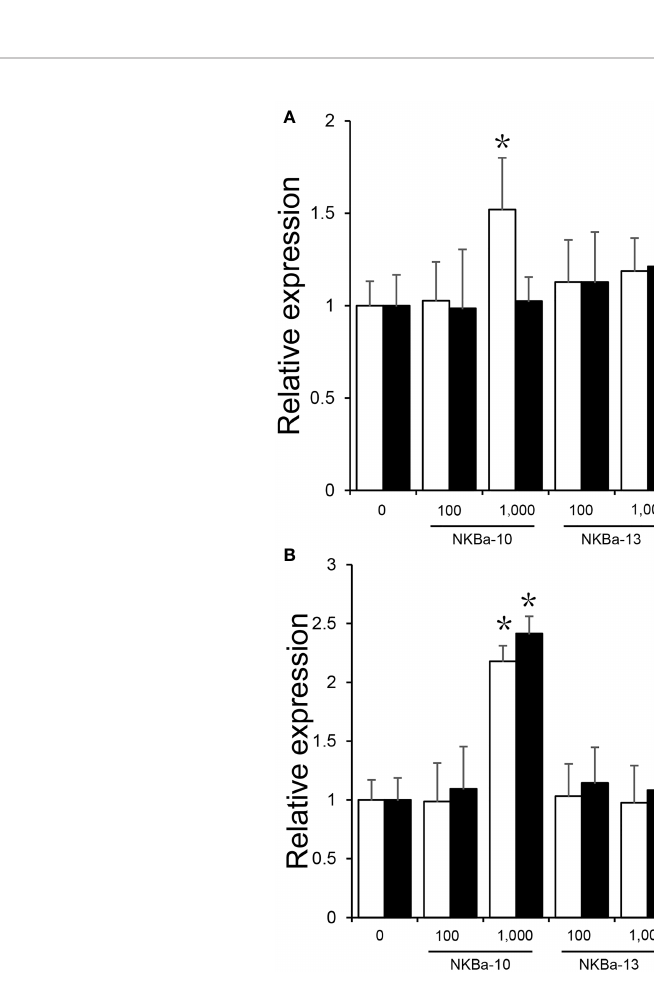
FIGURE 9 | (A) Effects of NKBa-10, NKBa-13, NKBb-10, and NKBb-13 on mgnrh and cgnrh expression of Japanese eel after intraperitoneal injection for 6 h. The X-axis indicates the different NKB peptides and their corresponding concentrations. (B) Effects of NKBa-10, NKBa-13, NKBb-10, and NKBb-13 on fshb and lhb of Japanese eel after intraperitoneal injection for 6 h. The X-axis indicates the different NKB peptides and their corresponding concentrations. The asterisk indicated signi fi cant difference of one gene among different stimulate concentration ( P < 0.05).